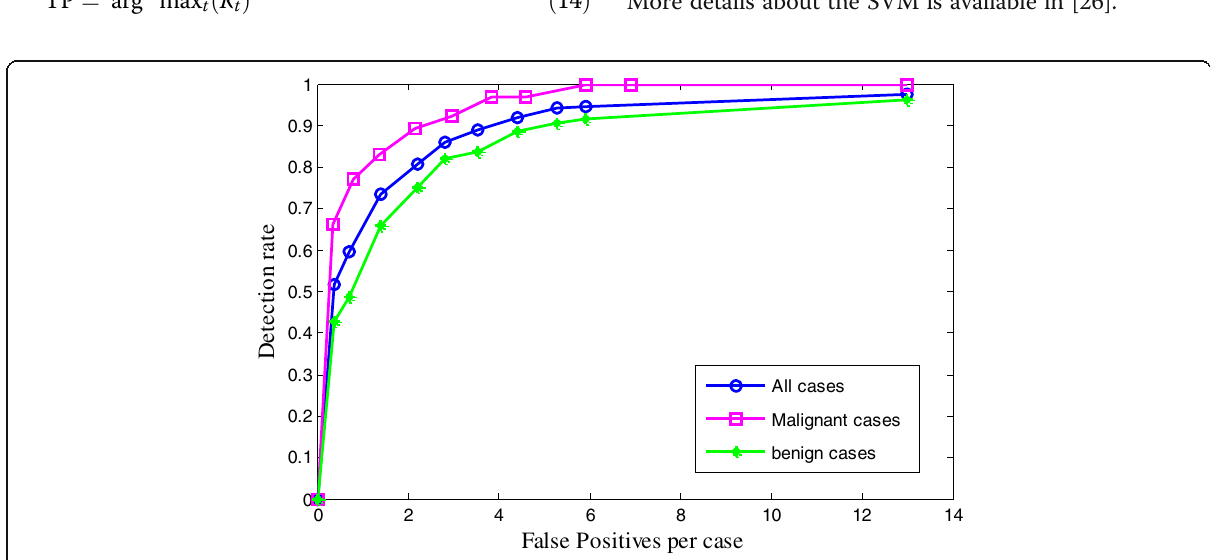
Fig. 10 The performance of the proposed CAD system for benign and malignant lesions